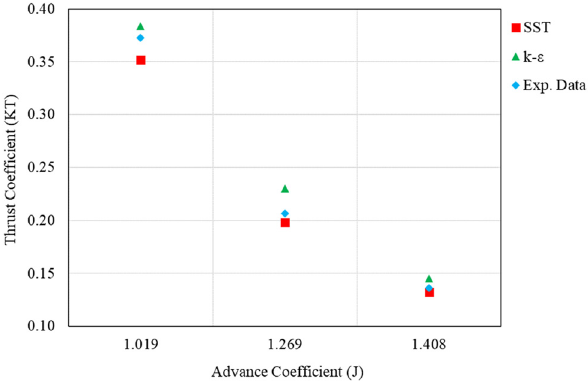
Figure 15: Numerical results of torque coe ffi cient K 10 Q ( ) of the Kunz cavitation model.